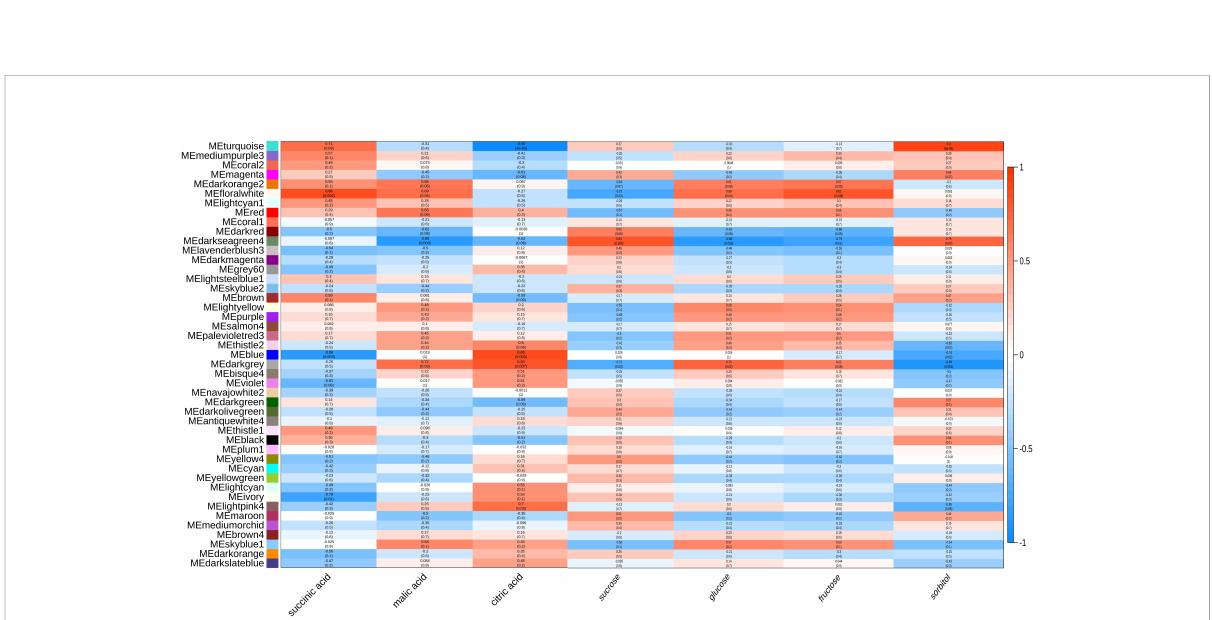
FIGURE 5 Weighted gene co-expression network analysis among genes associated with the sugar and organic acids content. Module-trait correlations and corresponding P values were presented. Each column represents a physiological trait, and each row represents a genetic module. The color scale shows module trait correlations from -1 (blue) to 1